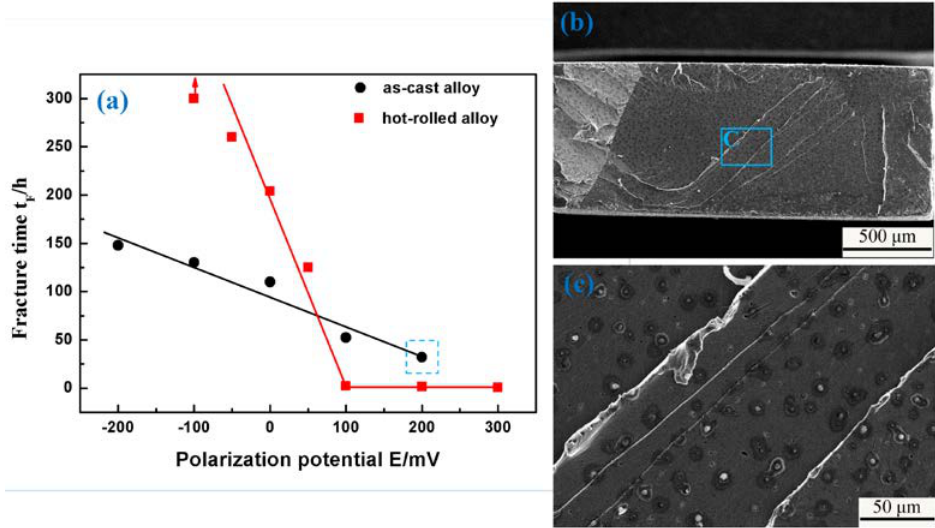
Figure 8. ( a ) Fracture time vs. polarization potential in the 3.5 wt % NaCl solution; ( b ) SEM fracture surface of the data point of blue dashed rectangle in ( a ); ( c ) magnified of the part of blue rectangle.